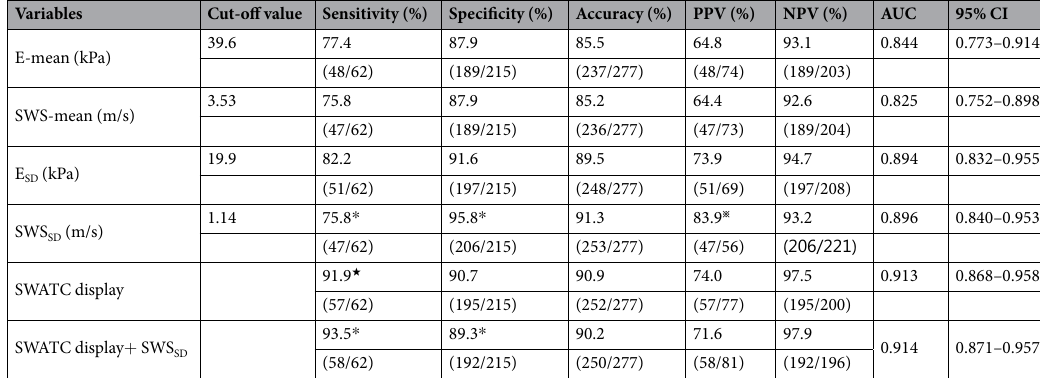
Table 3. The Diagnostic Performances of all the SWE Methods. SWS SD = standard deviation of shear wave speed; E-mean = the mean elasticity; E SD = standard deviation of elasticity; SWS-mean = the mean shear wave speed; PPV = positive predictive value; NPV = negative predictive value; CI = confidence interval; AUC = area under characteristic curve; SWATC = shear wave arrival time contour. * There are statistically significant difference between sensitivity and specificity of SWS SD and SW arrival time contour + SWS SD. (P < 0.05) ★ SW arrival time contour display showed higher sensitivity compared with E-mean, SWS-mean, and SWS SD with statistically significant difference. (P < 0.05) ※ SWS SD had higher PPV compared with E-mean, SWS-mean, E SD , SWATC display and SW arrival time contour + SWS SD with statistically significant difference (P <